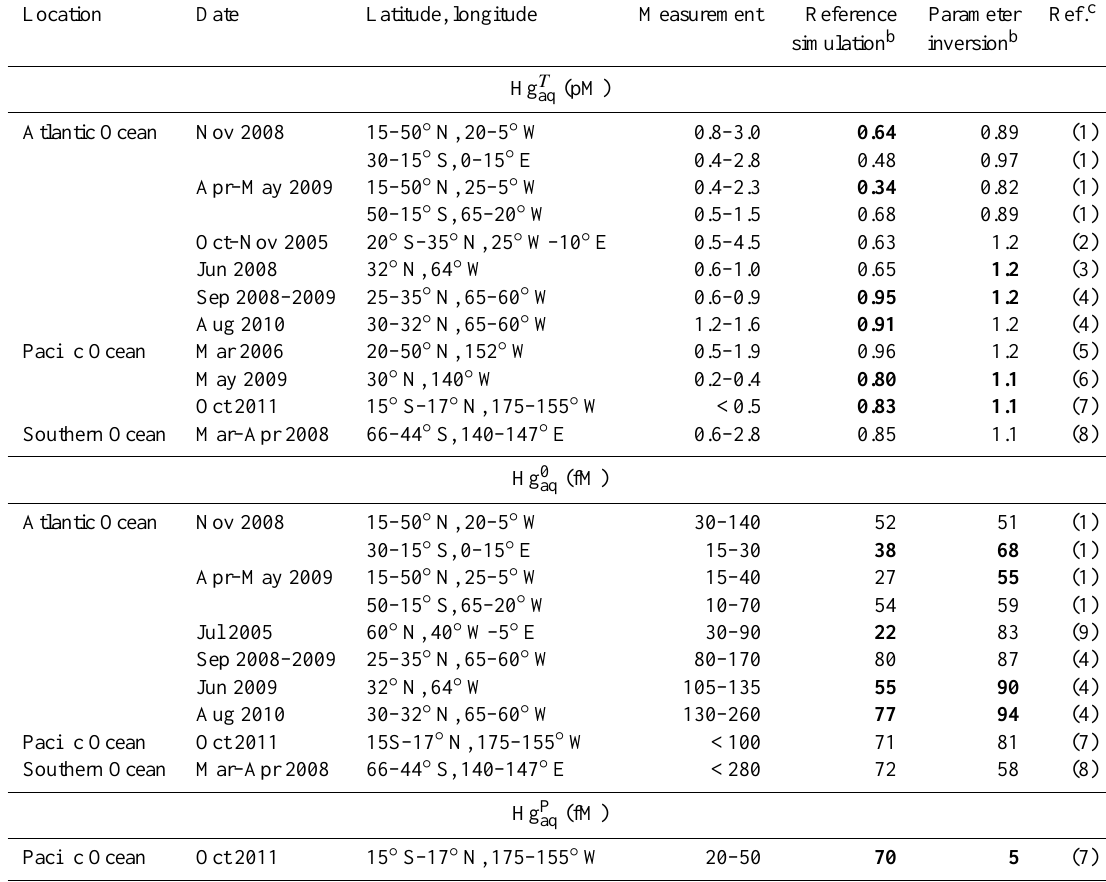
Table 5. Recent surface ocean mercury measurements and simulated concentrations.